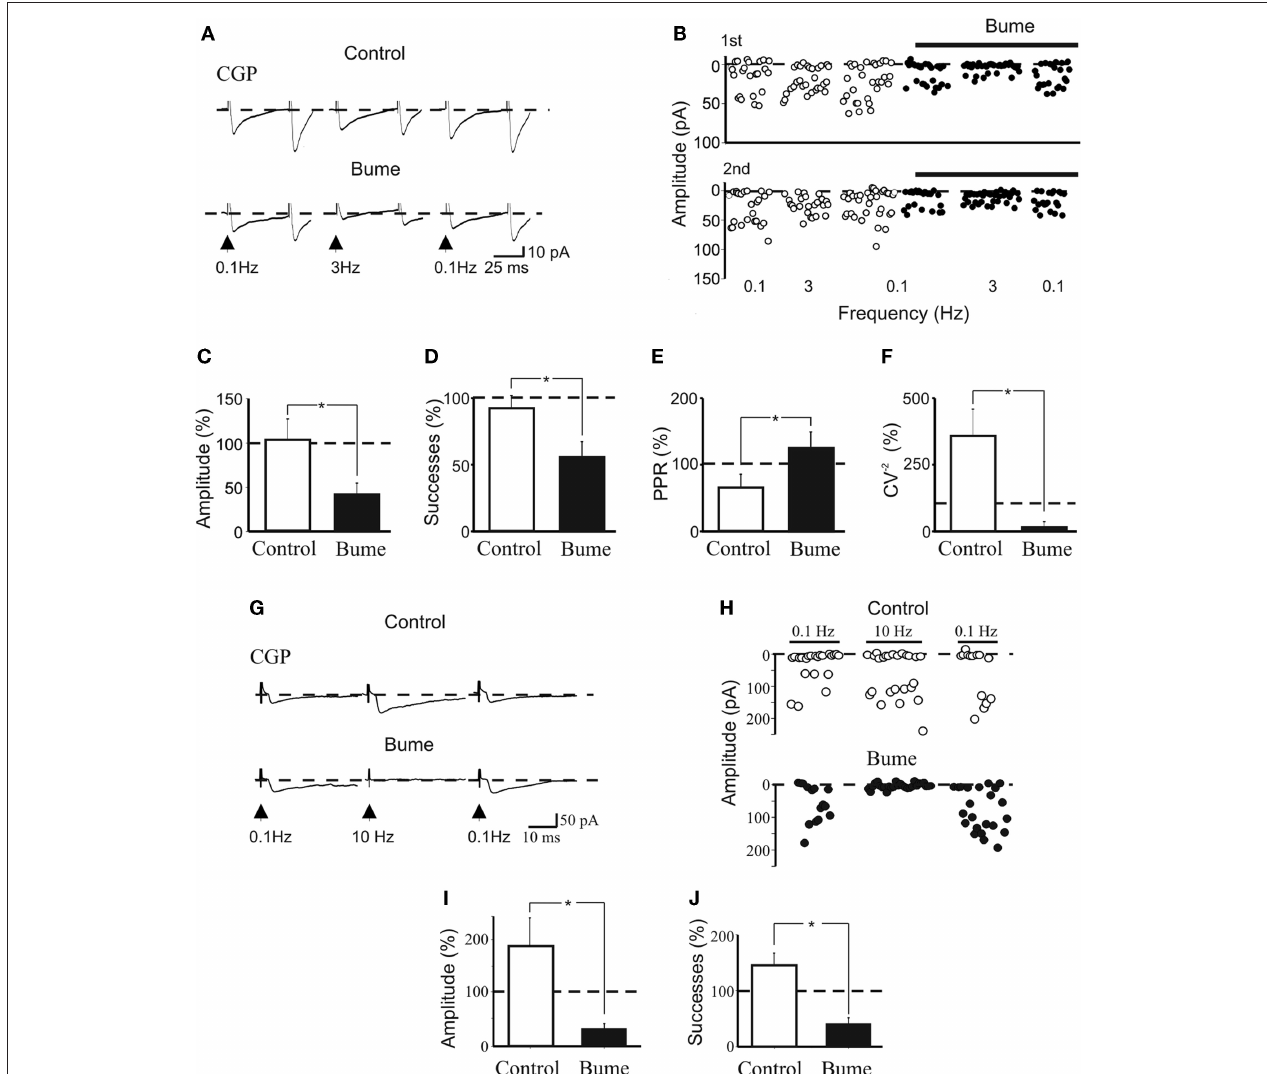
FIGURE 5 | Prevention of frequency-dependent depression by CGP 55845 requires the depolarizing action of GABA on MF terminals. (A) Synaptic currents evoked in the presence of CGP 55845 (1 μ M) in control conditions (upper traces) and after 30 min perfusion with bumetanide (10 μ M, lower traces) at 0.1 Hz (left), at 3 Hz (middle) and again at 0.1 Hz (right). Each trace is the average of 10–15 individual responses. Note synaptic depression at 3 Hz in the presence of bumetanide. (B) The peak amplitude of synaptic currents shown in (A) in control (open circles) and during bumetanide (closed circles) are plotted as a function of different frequencies (shown below). (C–F) Summary data ( n = 5) representing changes in amplitude (C) , success rate (D) , PPR (E) and CV − 2 (F) obtained at 3 Hz (normalized to the responses obtained at 0.1 Hz) in